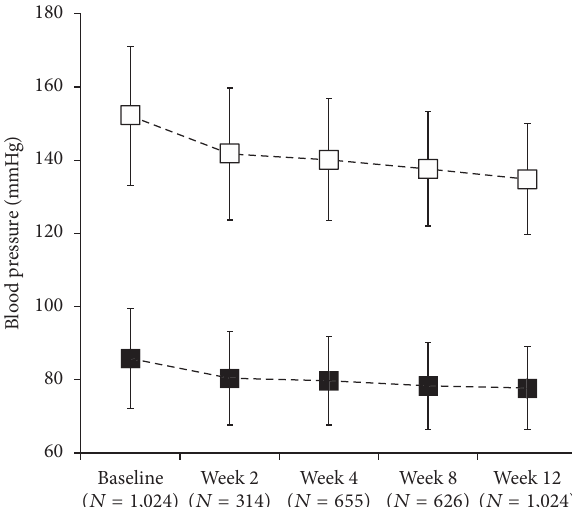
Figure 1: Changes in systolic (open square) and diastolic (closed square) blood pressure at each observation time point from baseline to week 12 (mean ± standard deviation) during the 12-week treat- ment period in the effectiveness analysis population. Figure 2: Changes in systolic blood pressure (mean